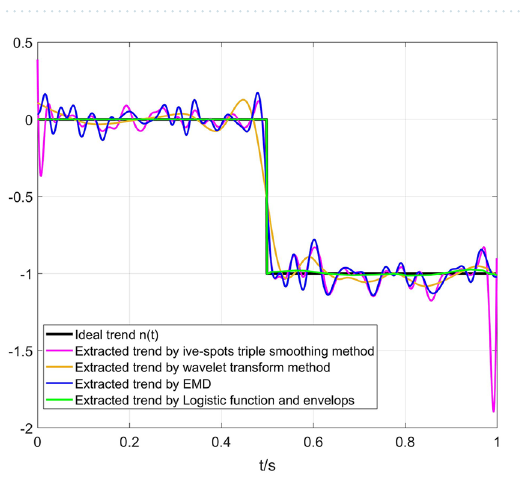
Figure 7. Spectrum of signals using different methods.